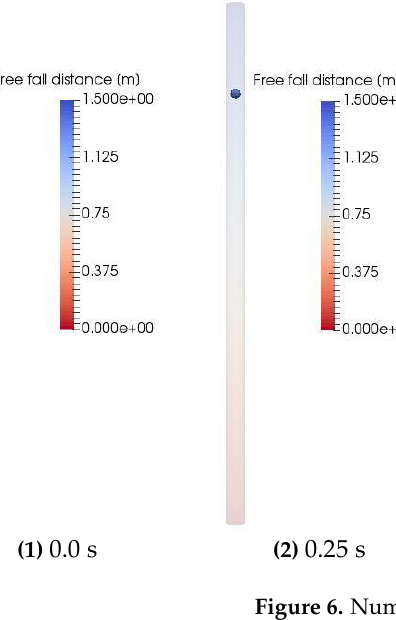
Figure 7. Comparison results for underwater drop test of bearing steel sphere. As shown in Figure 7, both the FSI analysis results and the CFD analysis results, excluding the results of the theoretical solution, represented almost complete solution convergence and also had high agreement with the actual test results. Through a comparative review of the bearing steel sphere, it was verified that significant results can